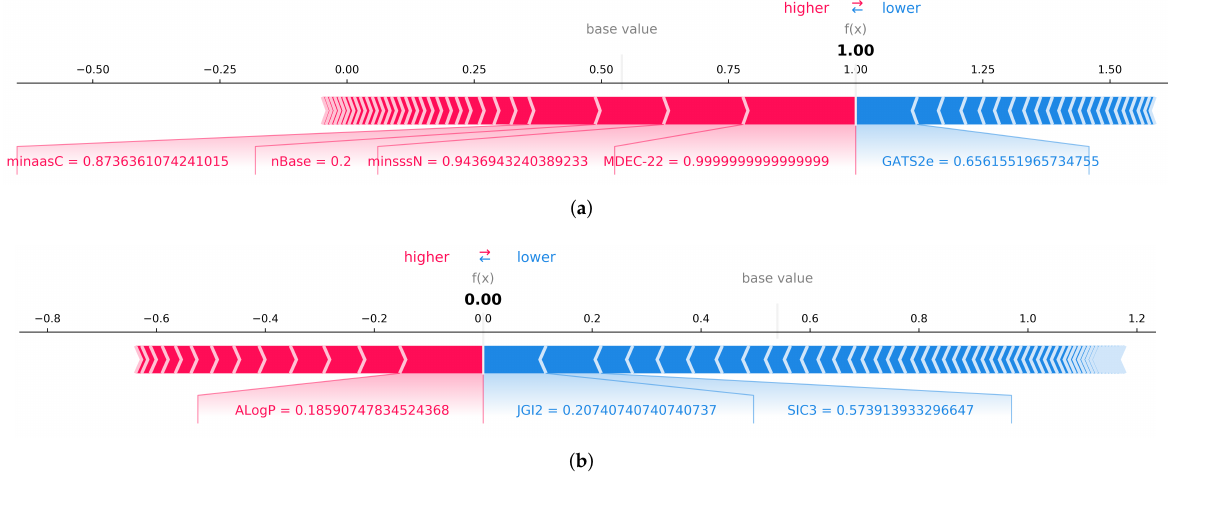
Table S4: The optimal parameter values of the machine learning models; Table S5: The performance of various single and hybrid feature selection methods; Table S6: The details of the selected optimal descriptors; Table S7: The performance of machine learning classifiers using the optimal